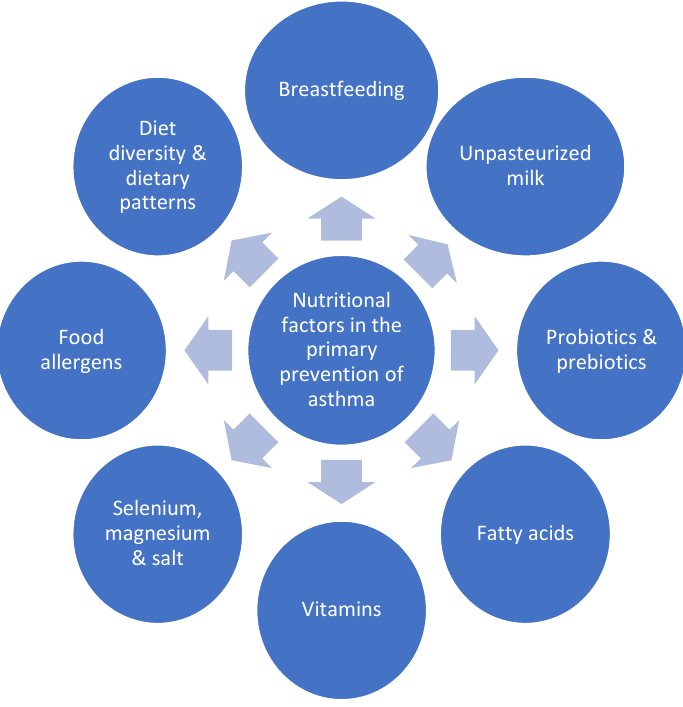
Figure 1. Nutritional factors with possible impact on the primary prevention of asthma.